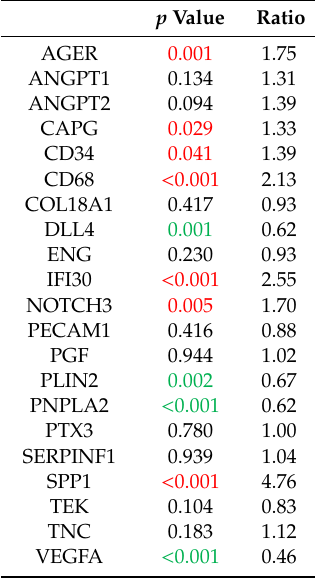
Table 2. Di ff erential transcriptomic expression between subcutaneous adipose tissue (SAT) of individuals with normal weight and individuals with obesity.